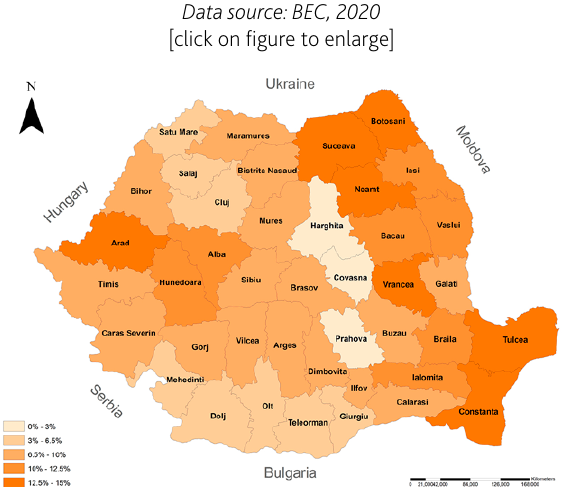
Figure 6. Proportion of AUR votes on